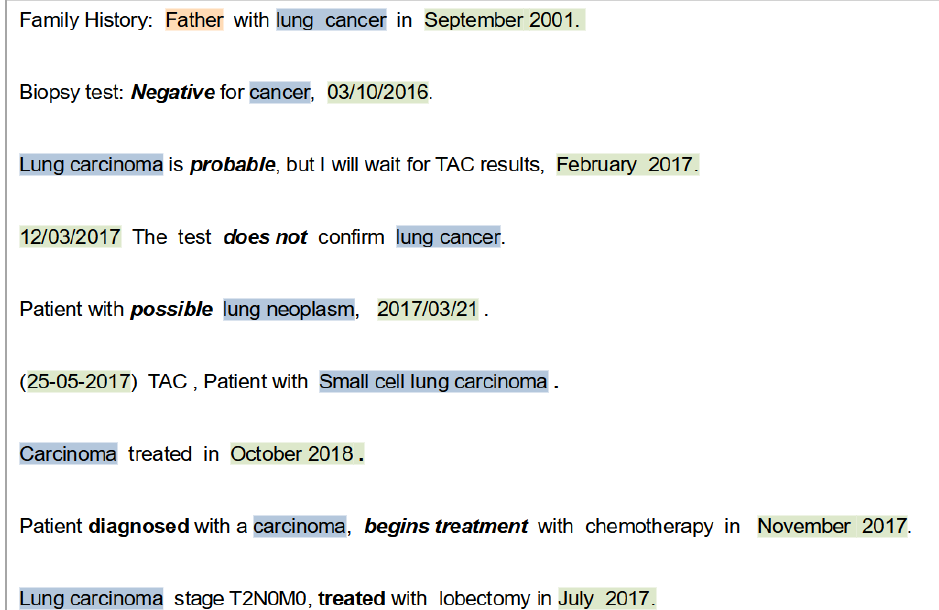
Figure 1. Medical history